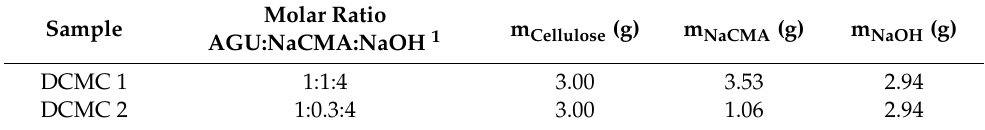
Table 1. Conditions for dicarboxymethyl cellulose (DCMC) polymers